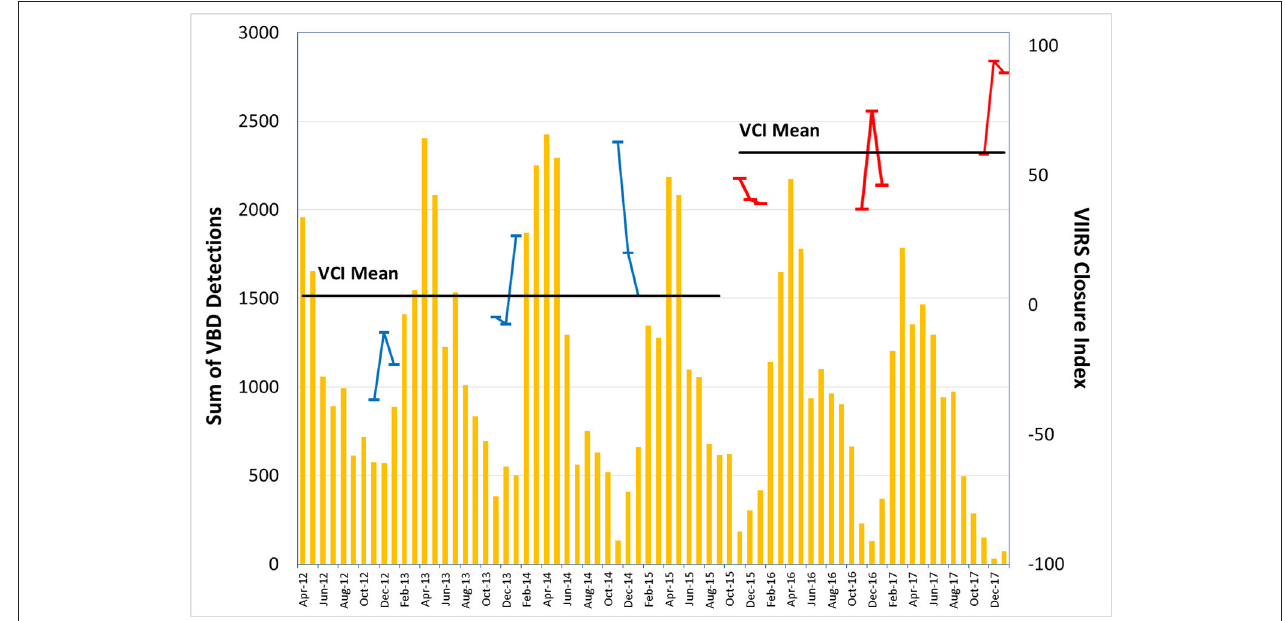
FIGURE 6 | The vertical bars indicate the monthly VIIRS boat detection tallies for the Palawan closure area from April 2012 through January 2018. The points with connecting lines indicate the VCI values, with the axis labels on the right. The closure VCI are red and pre-closure blue.